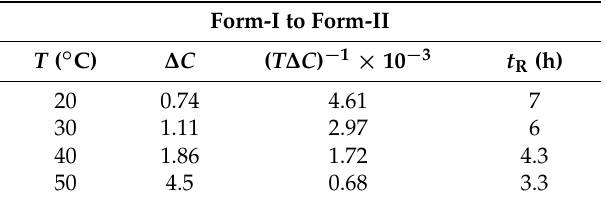
Table 2. Correlation of reconstruction time with respect to parameters of mass transfer model.